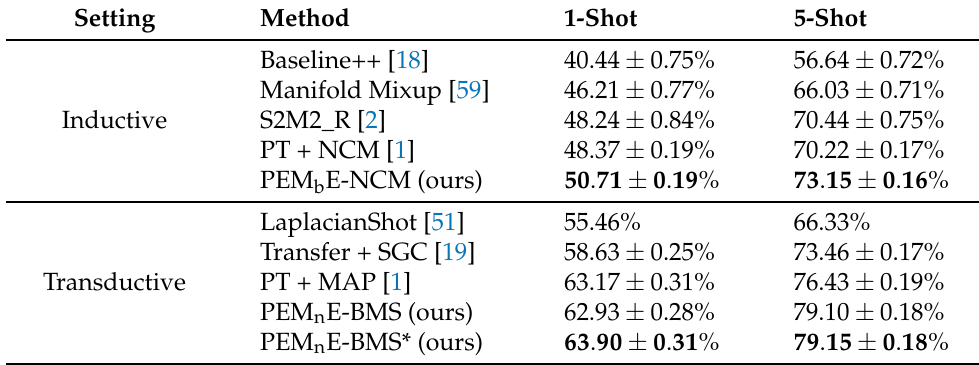
Table 3. The 1-shot and 5-shot accuracy of state-of-the-art methods when performing cross-domain classification (backbone: WRN). Best results are in